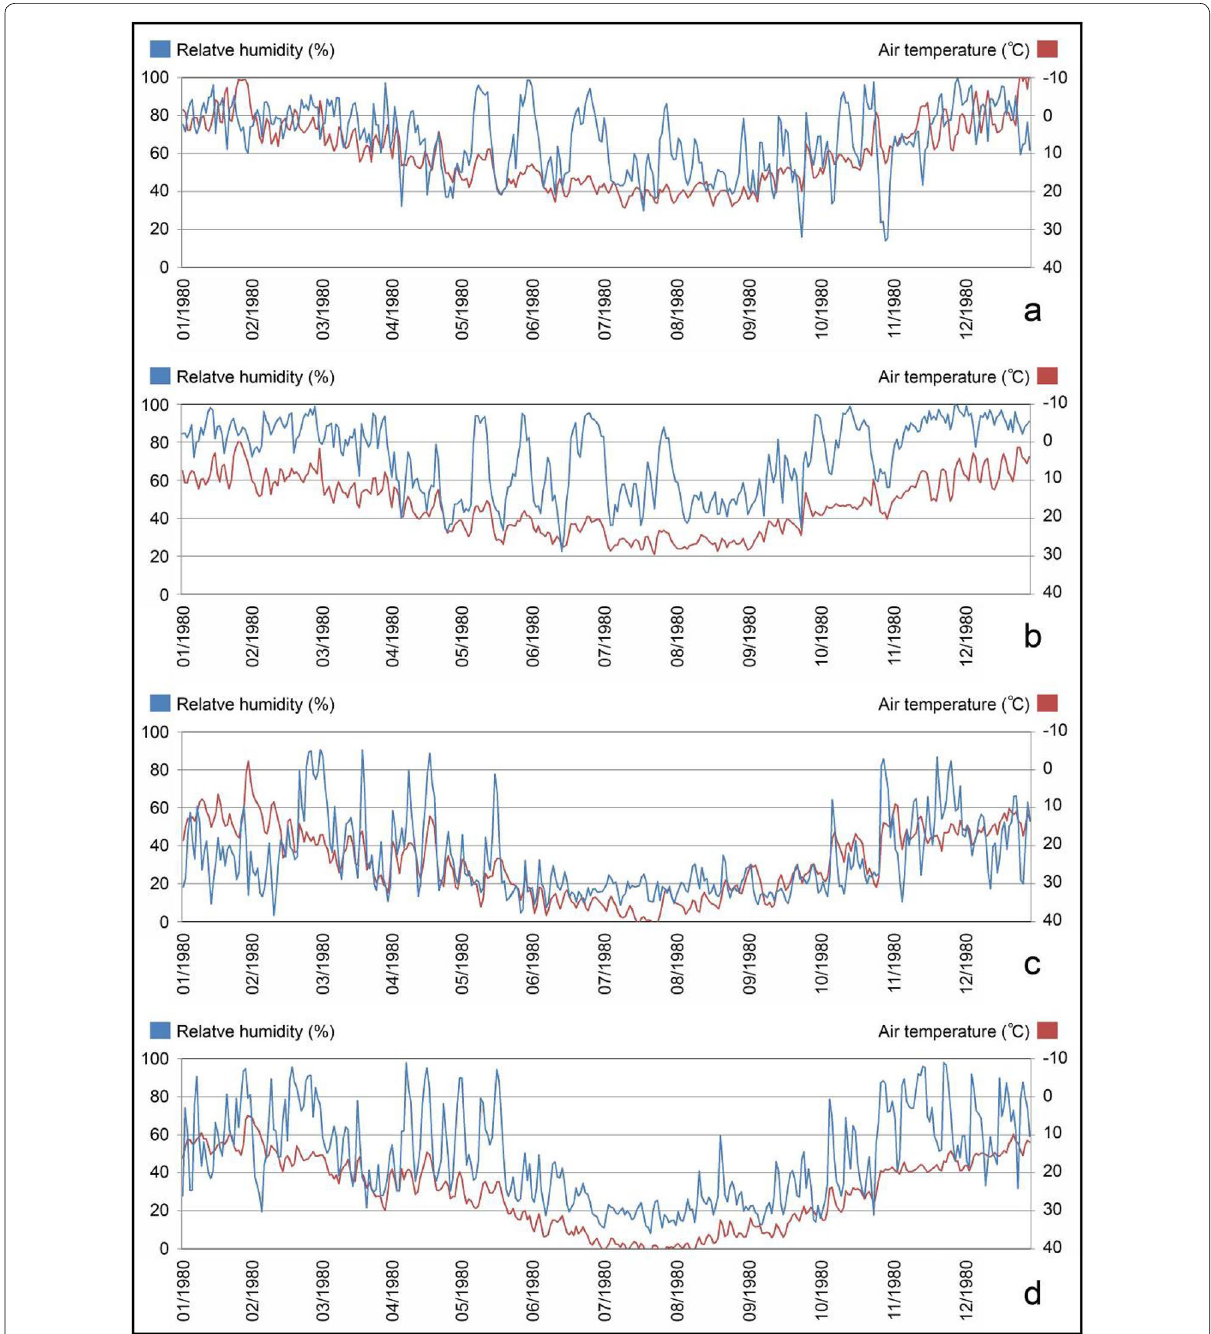
Fig. 3 Adjusted rescaled plot of temperature and relative humidity in daily scale for a Ankara, b Istanbul, c Mashhad, and d